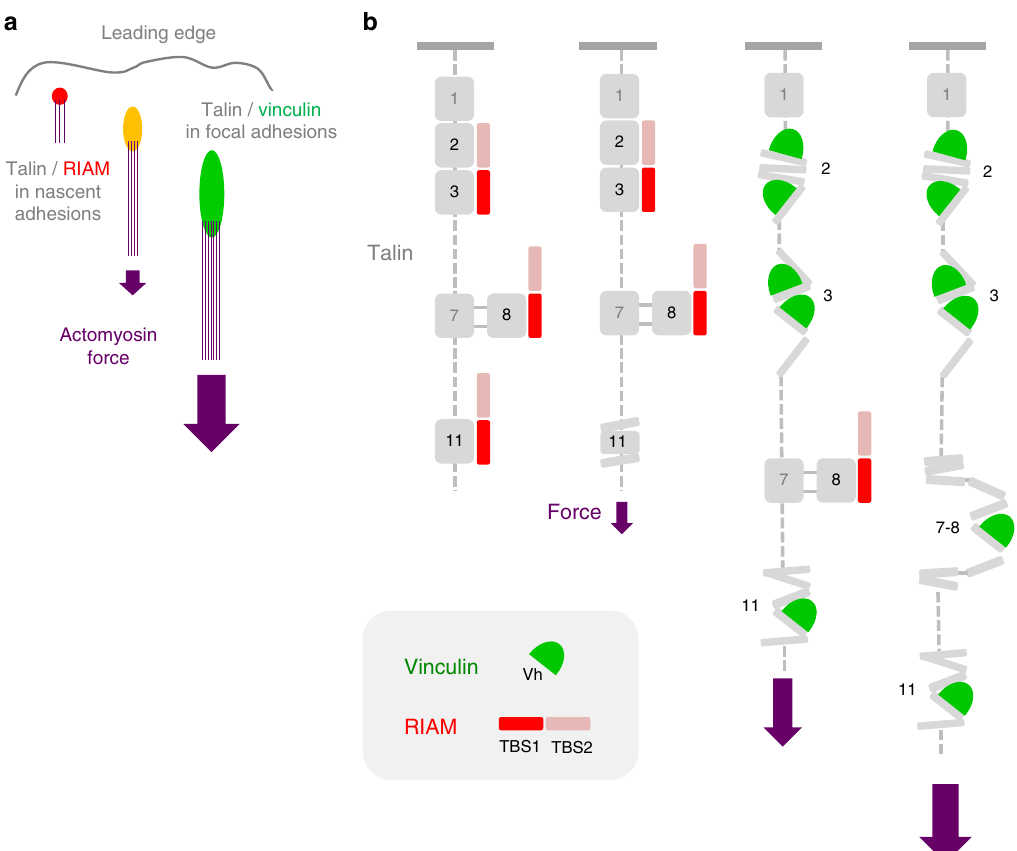
Fig. 6 Model for the actomyosin-dependent binding of RIAM and vinculin to talin. a Scheme illustrating that RIAM, which is initially enriched in nascent adhesions, is replaced by vinculin in mature FAs in response to the force exerted by the actomyosin stress fi bers. b Model describing how talin dissociates from RIAM and associates to vinculin sequentially in response to the actomyosin